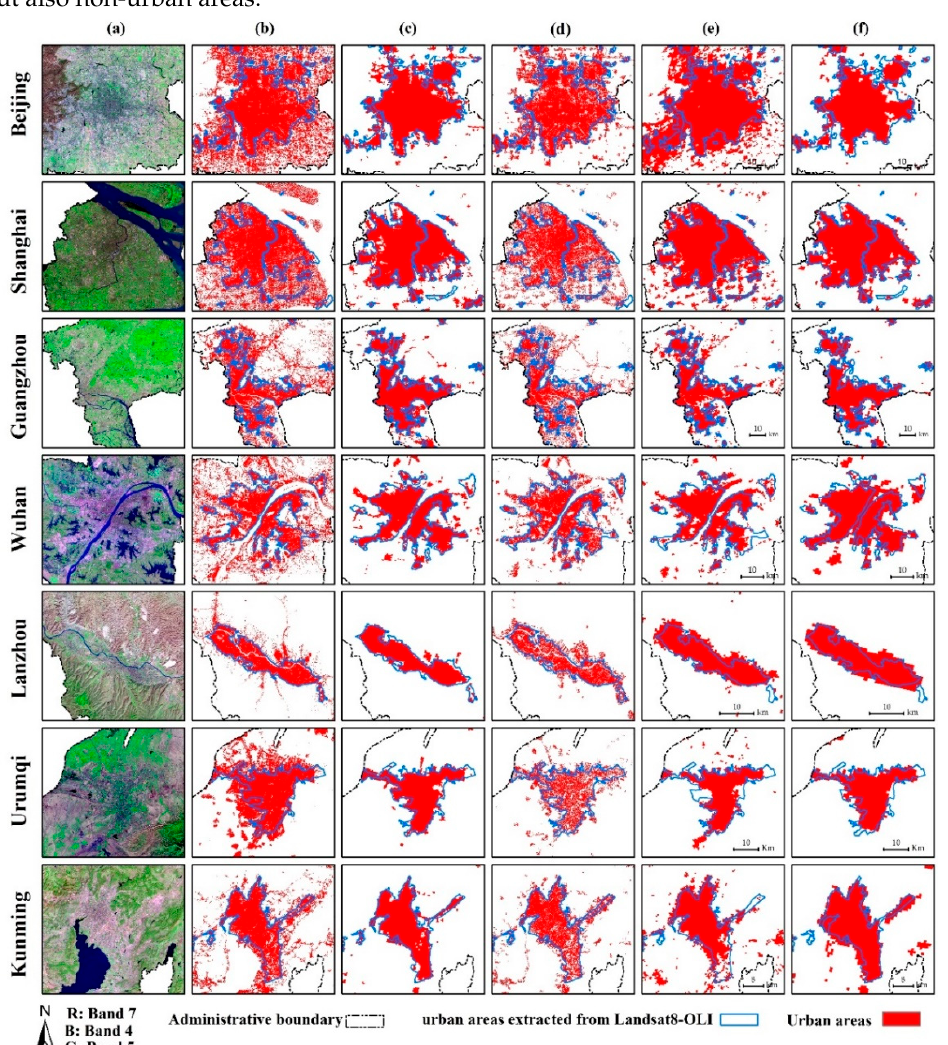
Figure 8. Comparing the urban pattern and spatial details between our results and other products ( a ) Landsat8 OLI Images (30 m), ( b ) the global artificial impervious area (GAIA) (30 m), ( c ) our results (500 m), ( d ) the global urban land based on a normalized urban areas composite index (NUACI-based GUL) (30 m), ( e ) the MODIS 500 (500 m), ( f ) the global urban expansion product based on a fully convolutional network (FCN) (500 m). Table 3. Comparing our results in the year 2015 with other products.